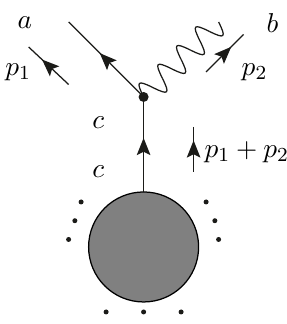
Figure 13 . Feynman diagrams leading to collinear gaugino and gauge boson